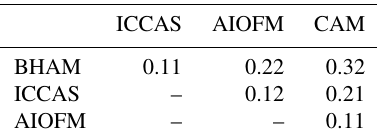
Table 3. Calculated CD values for each instrument pair during the winter intercomparison.